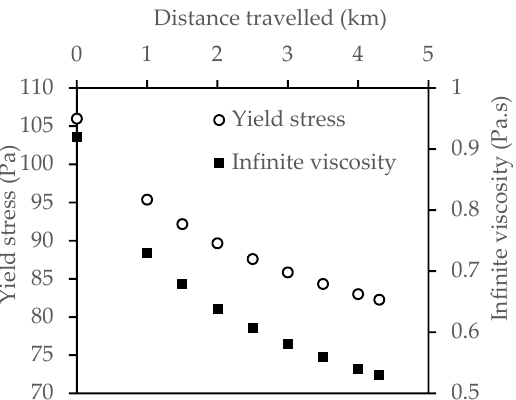
Figure 11. Effect of travel distance on the variation of yield stress and infinite viscosity for mixture M02 (data given in Table 2 with l ≤ 4.3 km).